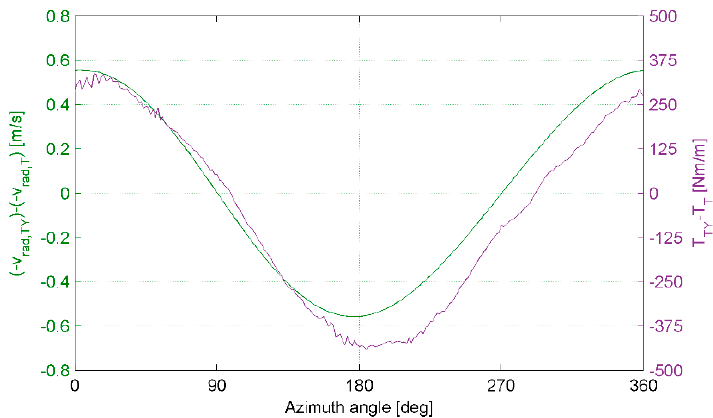
Figure 22. Comparison between the computed negative difference in radial velocity and the difference in torque at 75% of the blade.